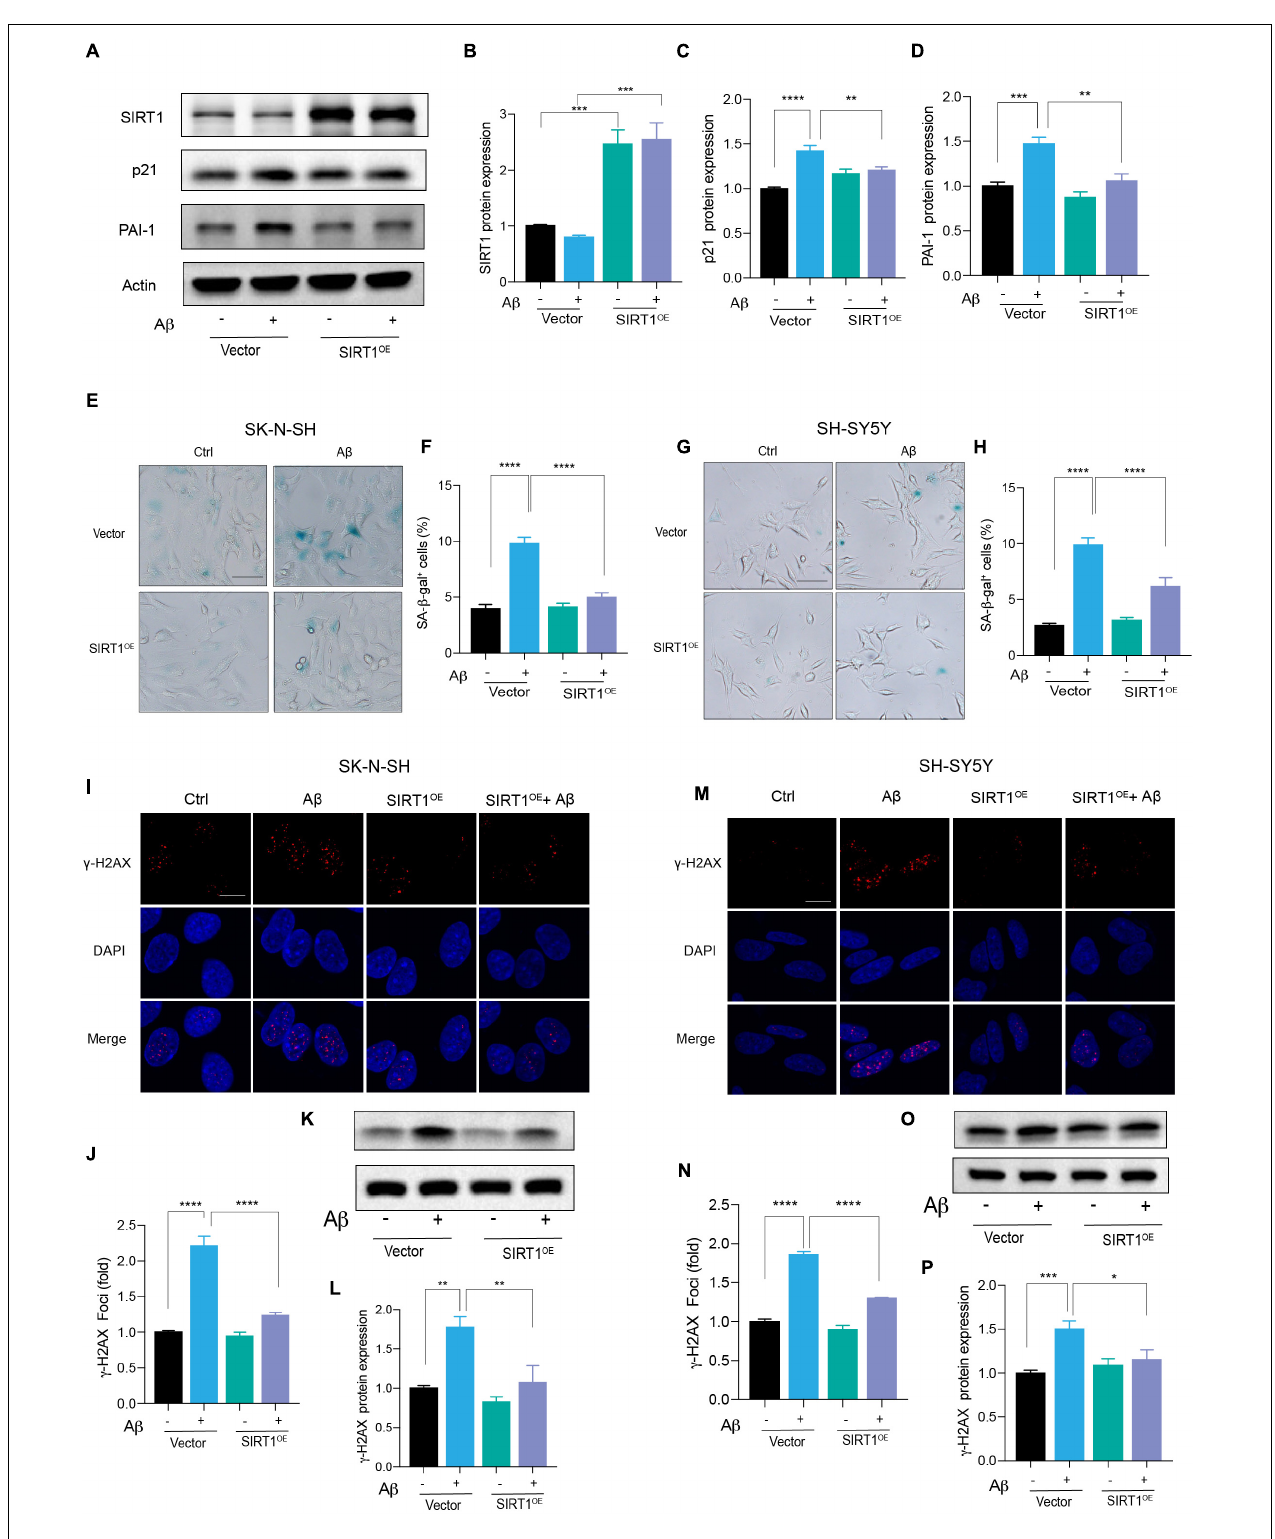
FIGURE 4 | Exogenous expression of SIRT1 rescued A β -induced cell senescence. (A) Cells were transfected with Vector and SIRT1 plasmid in SK-N-SH cells, and after 24 h transfection, cells were incubated with A β or without for another 72 h. Western blot analysis of SIRT1, p21, PAI-1 protein level. Actin was used a loading control. (B-D) Quantification of SIRT1 (B) , p21 (C) , and PAI-1 (D) protein level in (A). (E,F) The representative images of SA- β -gal staining in SK-N-SH cells treated with A β or without for 72 h, after transfected with Vector and SIRT1 plasmid for 24 h (E) . Quantification of relative number of SA- β -gal-positive cells in (F) .